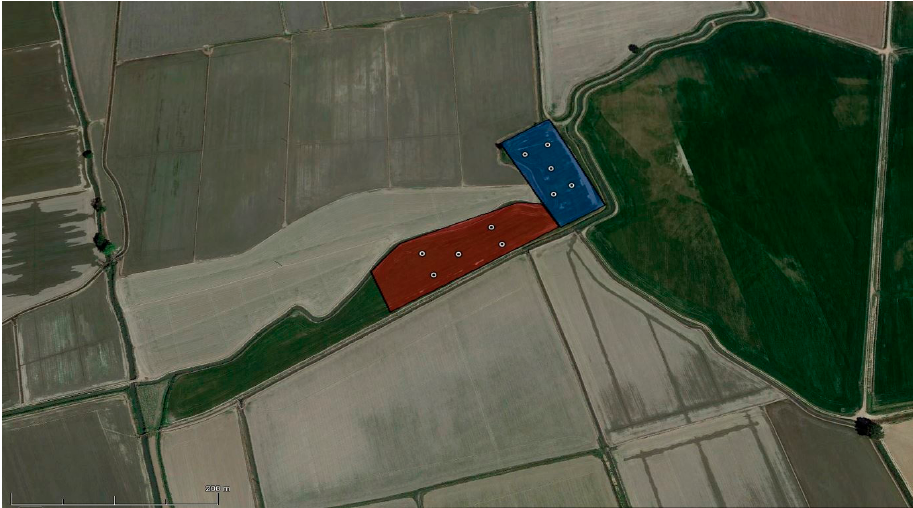
Figure 2. Experimental field with the sampling points highlighted in white circles.